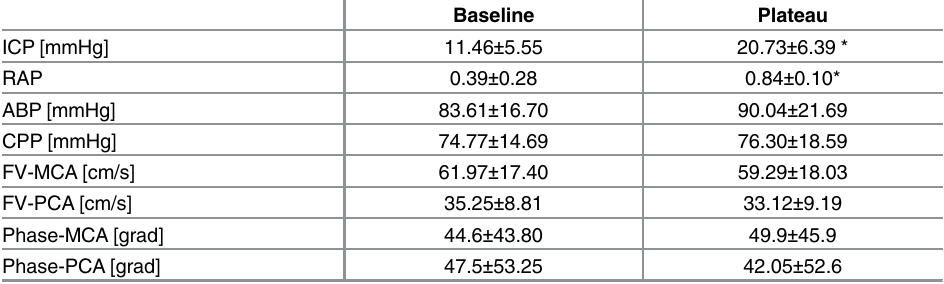
Table 1. Physiological parameters at baseline and plateau levels.